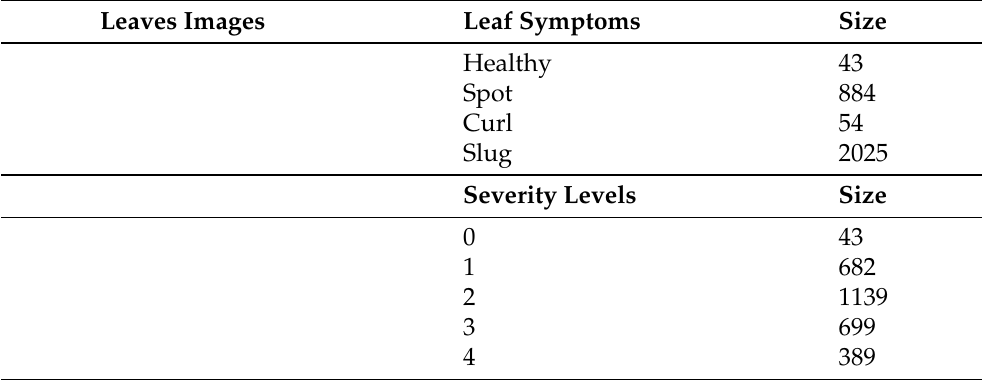
Table 2. DiaMOS Plant is a collection of 3505 images of fruits and leaves. The table illustrates the distribution of classes belonging to the leaf images.